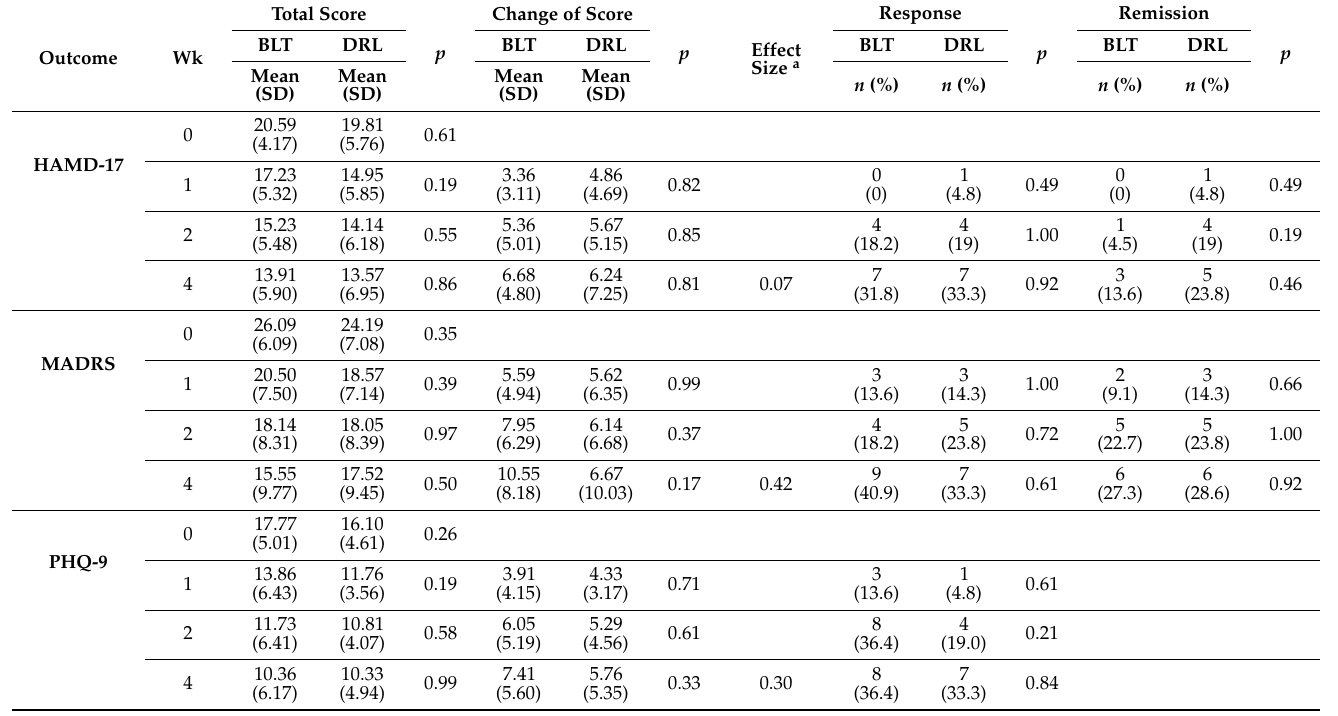
Table 3. Outcome measures in treating major depressive disorder over time using bright light therapy ( n = 22) and dim red light ( n =